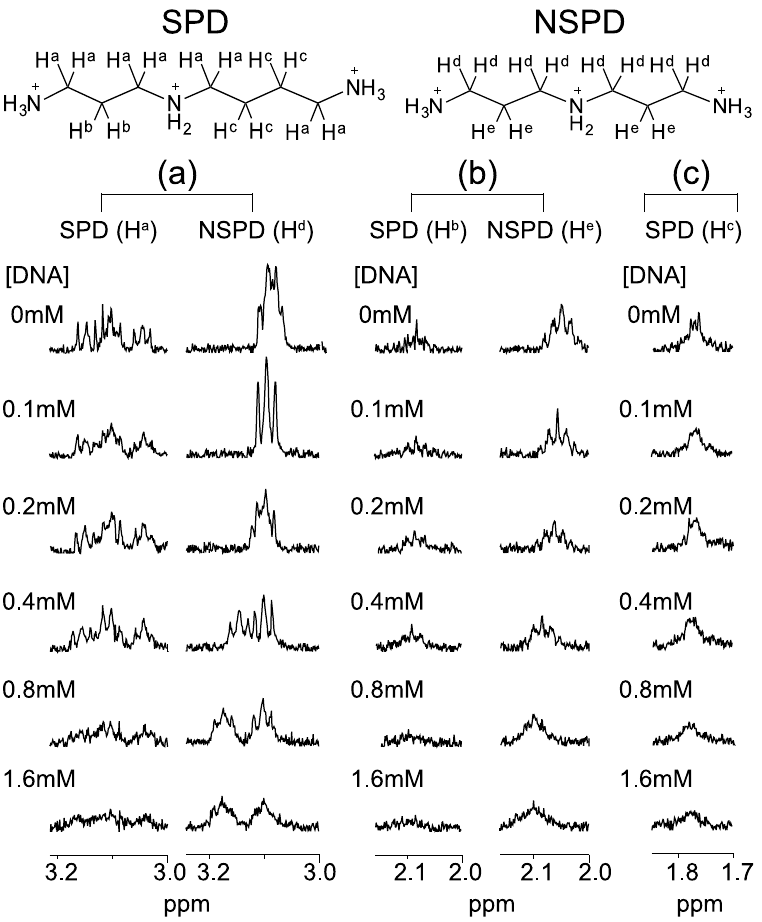
Figure 4. 1 H NMR spectra for methylene groups of SPD and NSPD at different concentrations of CT DNA. The polyamine concentration was fixed at 0.1 mM. ( a ) δ = 3.20–3.00 ppm, ( b ) 2.15–2.00 ppm, and ( c ) 1.85–1.70 ppm.